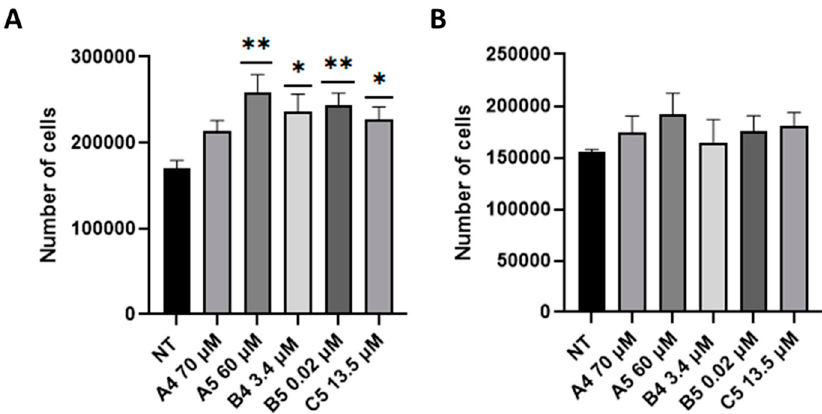
Figure 2. Analysis of cell proliferation following GEs administration. ( A ) SUP-T1 and ( B ) normal human primary fibroblasts cell proliferation after GEs administration at 24 h p.t. GEs were used according to the concentration reported in the BIOPEP database. Cytofluorimetric analysis was performed through Muse Cell Analyzer. Asterisks indicated p < 0.05 (*) or p < 0.01 (**), compared with non-treated (NT) cells, ANOVA One-Way test. Analysis was performed on four independent biological replicas with 1,000 events collected each. SEM bars are reported.